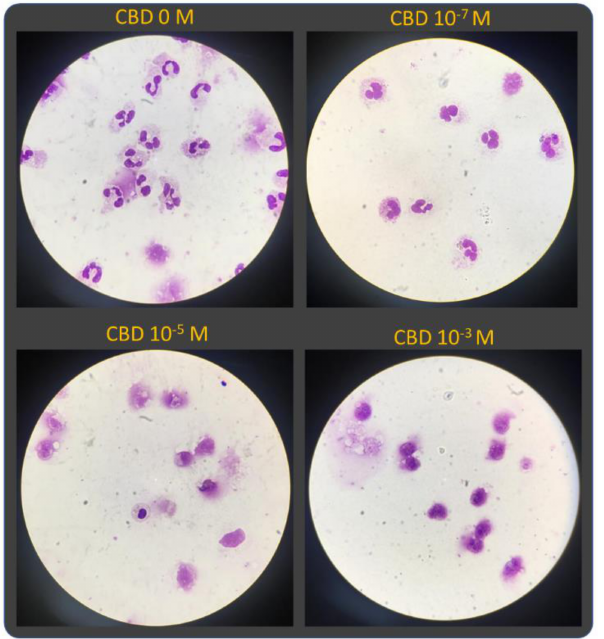
Figure 2. The morphology of PMNs is modified by CBD in a concentration-dependent manner. All images were captured with a magnification of 40 ×